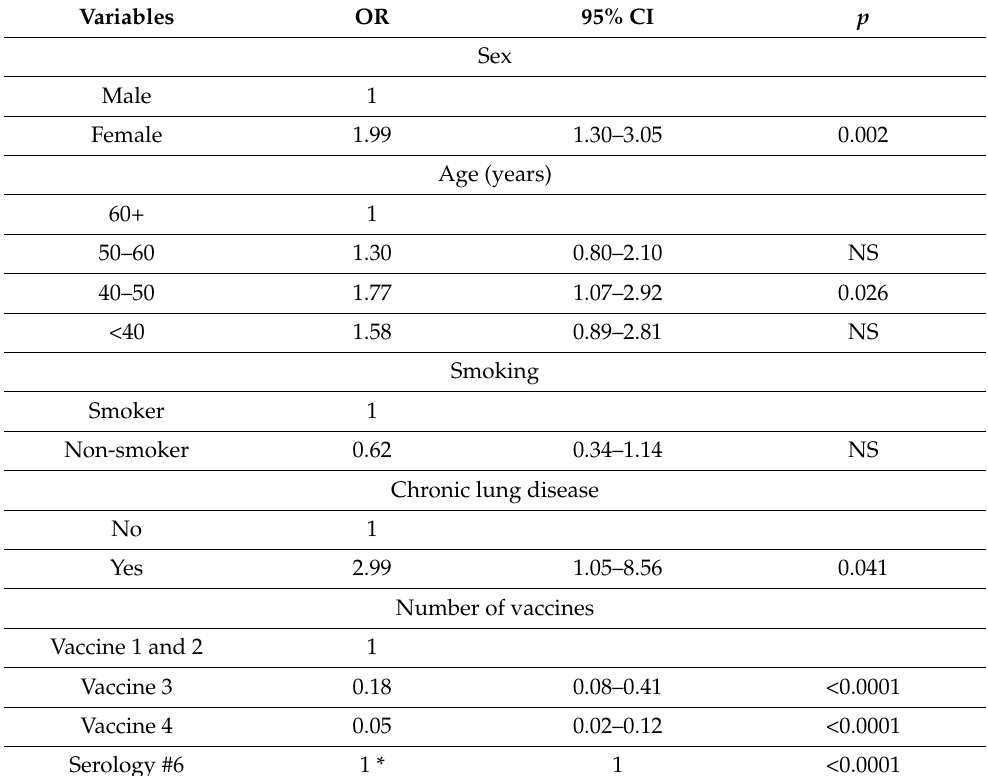
Table 1. Multivariate analysis of the independent factors associated with increased risk of SARS-CoV- 2 infection.